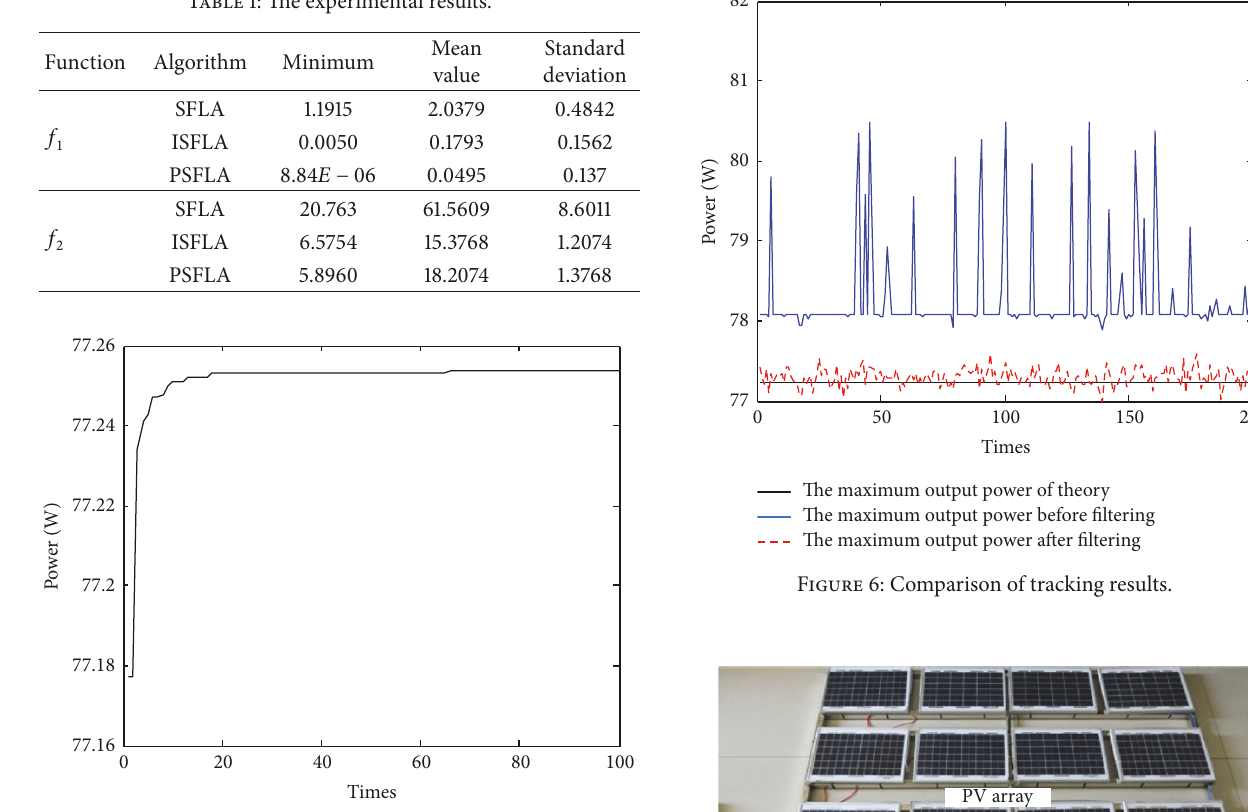
Figure 5: The power of PV array during search.